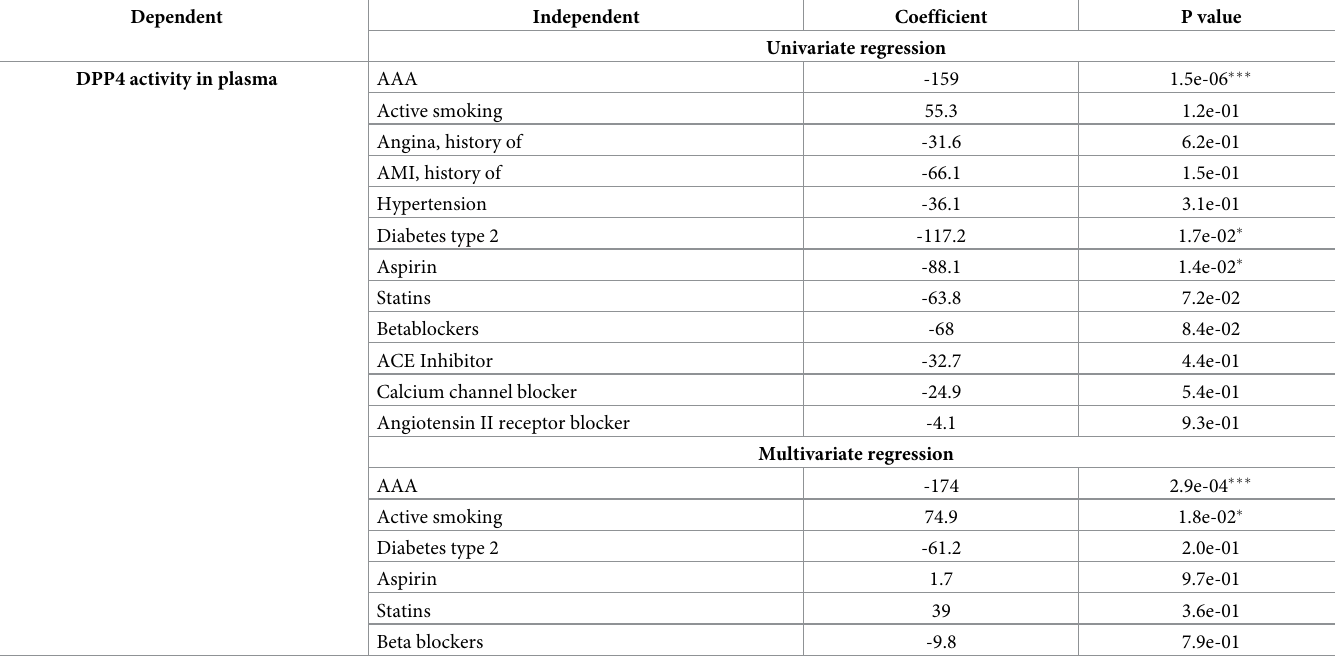
Table 2. DPP4 activity and patient characteristics.